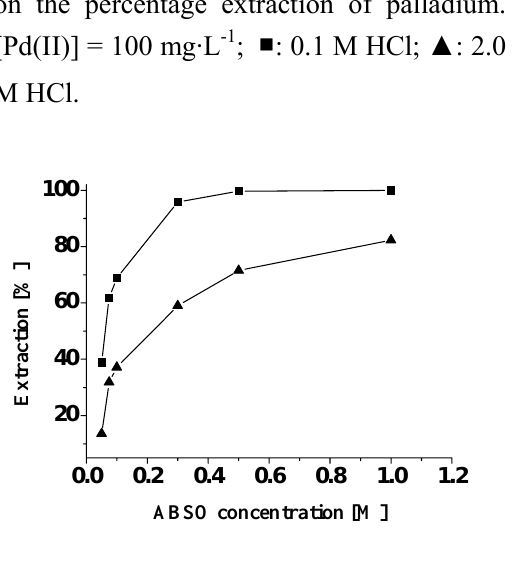
Figure 3 . Effect of HCl concentration on the percentage extraction of palladium. [Pd(II)] = 100 mg·L -1 ; Organic phase: 0.5 M ABSO in